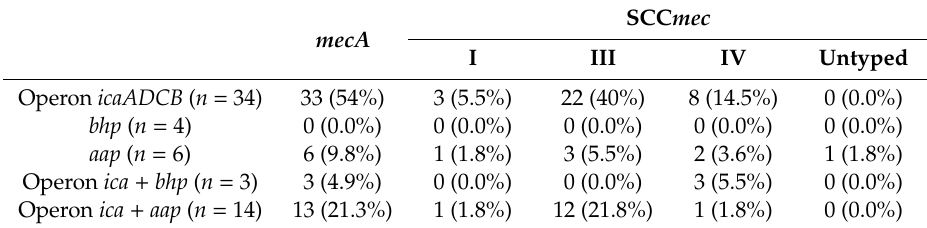
Table 3. Distribution of the agr locus, mecA gene, and Staphylococcal chromosomal cassette mec (SCC mec ) in S. epidermidis positive by the RT-PCR technique.